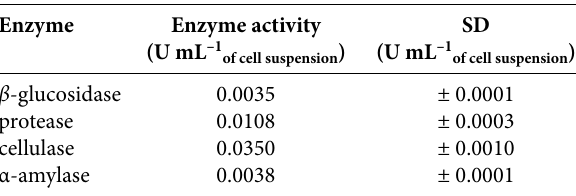
Table 2 : Initial activity of the studied enzymes in the T. salinum cell suspension before homogenization and standard deviation of meas- urements (SD).